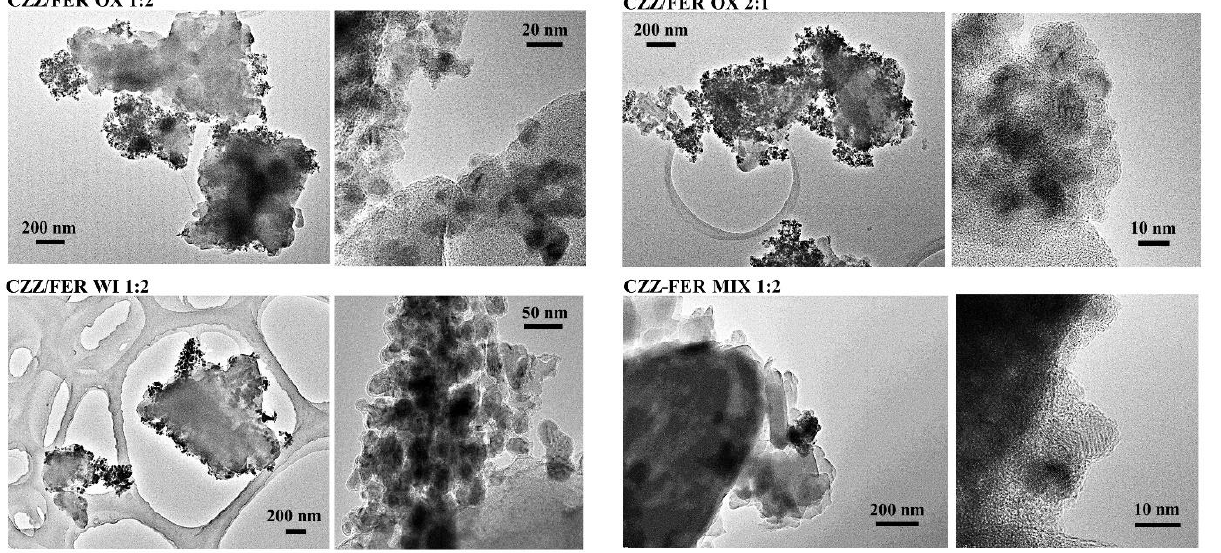
Figure 3. Bright-field TEM images of spent hybrid catalysts.